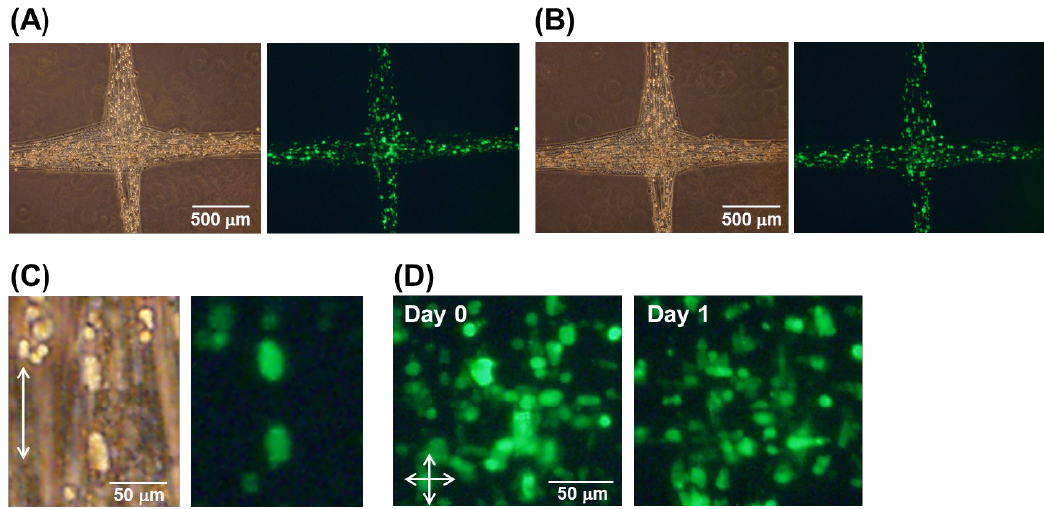
Figure 6. HUVECs embedded into hydrogel fibers after electrochemical gluing via Ca 2+ . The hydrogel fibers were cultured in culture medium. Phase-contrast and fluorescence images of the HUVECs after ( A ) 0 and ( B ) 1 day. ( C ) Magnified phase-contrast and fluorescence images after 0 days. The arrow indicates the direction of the hydrogel fibers. ( D ) Magnified fluorescence images at the crossing point after day 0 and day 1. Arrows indicate the direction of the hydrogel